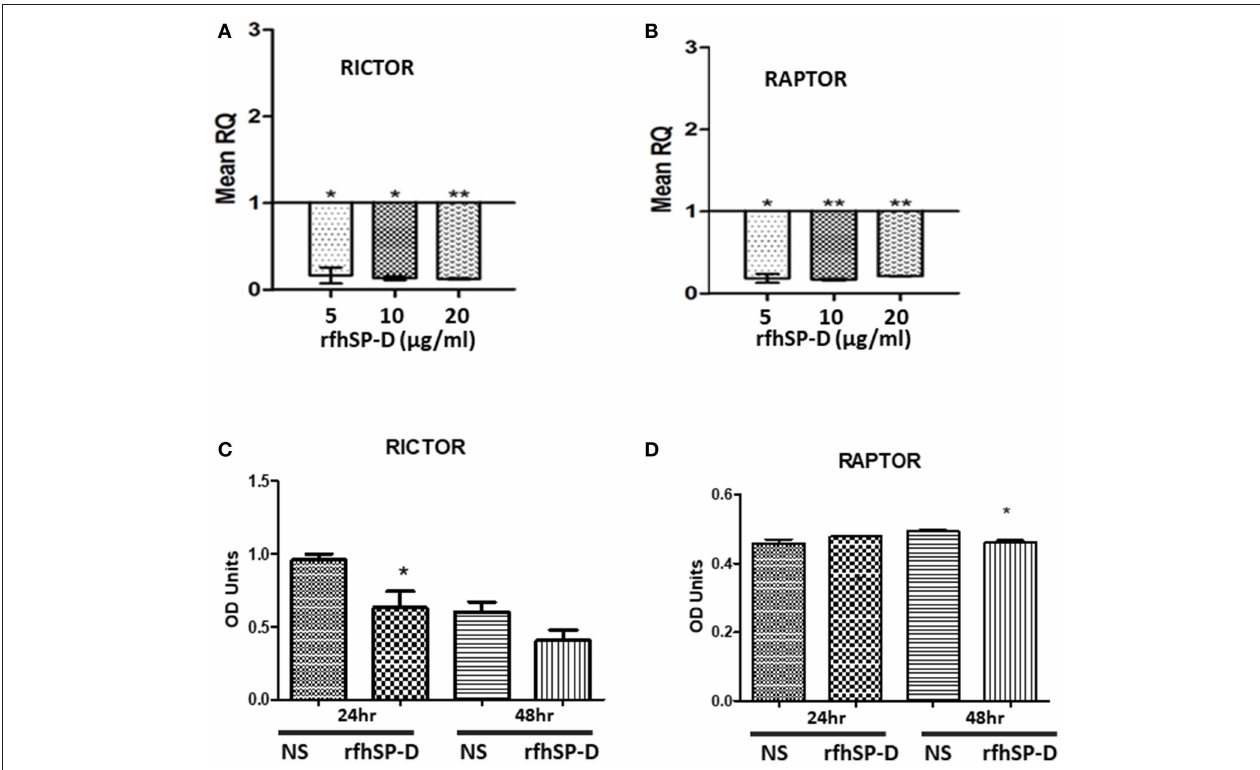
FIGURE 9 | Relative quantification of Rictor (A) and Raptor (B) mRNA expression in SKOV3 cells treated with 5, 10 and 20 µ g/ml of rfhSPD after 12h (* p < 0.05, ** p < 0.01 compared to basal levels set at 1.0). Western blotting for Rictor (C) and Raptor (D) showed a downregulation at protein level at 24 and 48h, respectively compared to controls; * P <